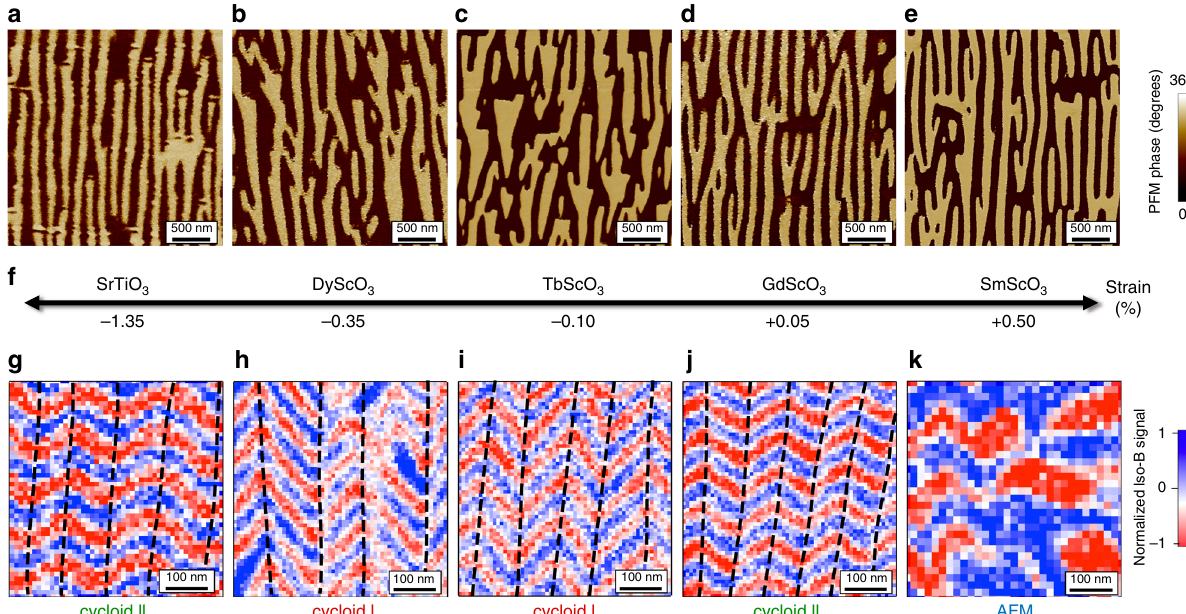
Fig. 2 Strain dependent magnetic textures on striped ferroelectric domains. a – e In-plane PFM phase images of BiFeO 3 fi lms grown on SrTiO 3 ( a ), DyScO 3 ( b ), TbScO 3 ( c ), GdScO 3 ( d ) and SmScO 3 ( e ) substrates. f Sketch of the evolution of the epitaxial strain in BiFeO 3 as a function of the substrate. g – k NV magnetometry images corresponding to the ferroelectric domains depicted in ( a – e ). The dashed lines in ( g – j ) are guides to the eyes, re fl ecting a change of the cycloid propagation vector associated to the ferroelectric domain walls. The symbol AFM in ( k ) stands for pseudo-collinear antiferromagnetic